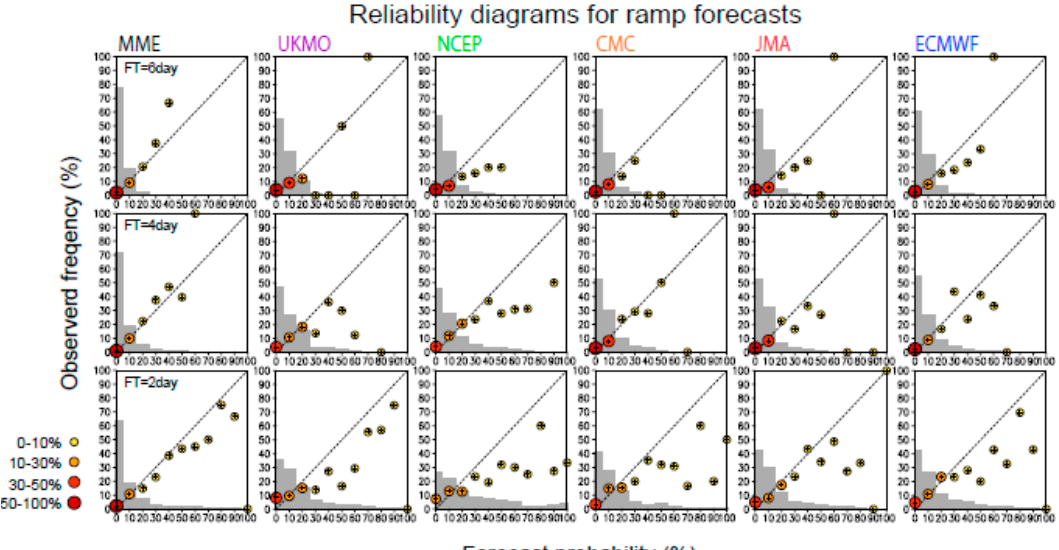
Figure 9. Reliability diagrams for two-day, four-day, and six-day forecasts of wind ramp events in the Tohoku region from April 2011 to May 2013 obtained from the MME and five single-center ensembles. Frequency histograms are represented by gray bars and dot colors.